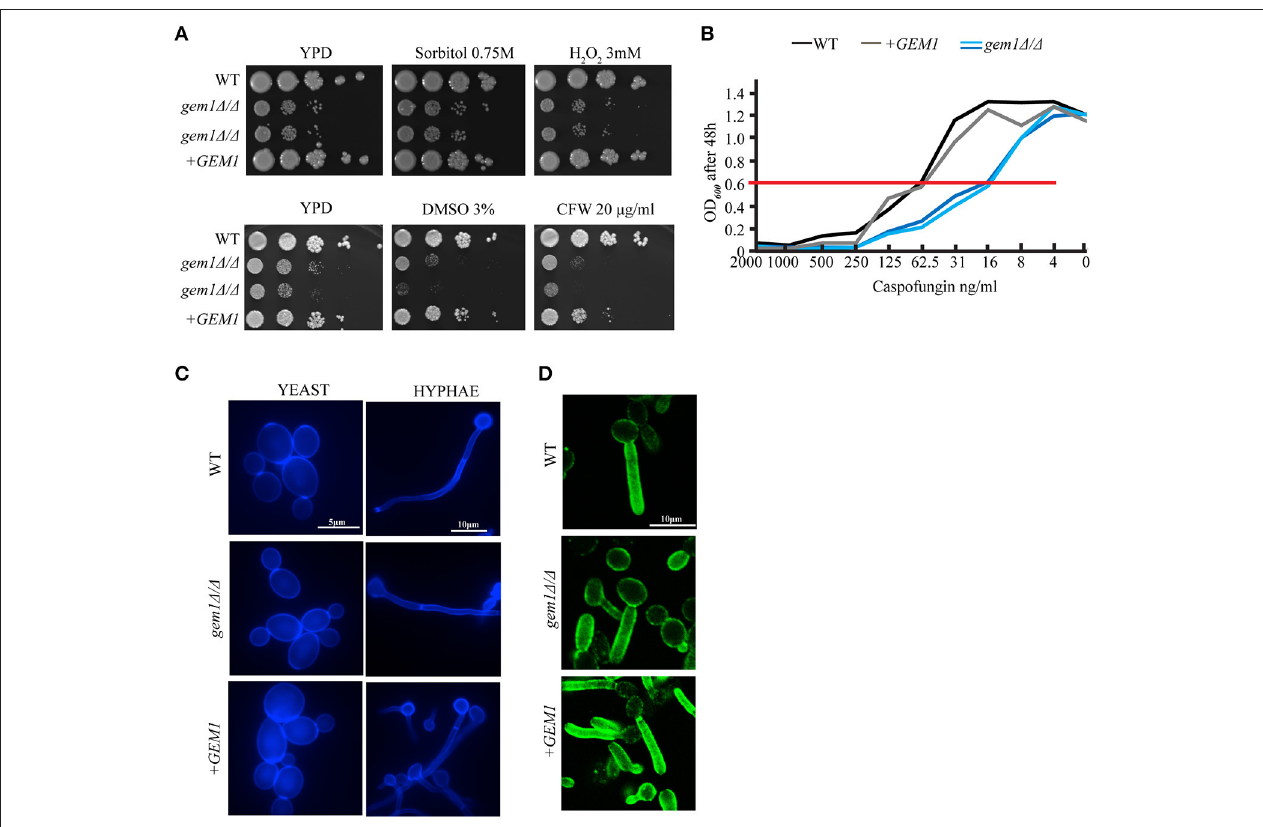
FIGURE 2 | Gem1 controls susceptibility to cell wall stress. (A) Growth of C. albicans wild type, gem1 1 / 1 mutants and the complemented strain ( + GEM1 ) was tested on YPD plates in the presence of the indicated drugs at 30 ◦ C. Ten-fold serial dilutions were spotted and plates were photographed after 2 days. (CFW, Calcofluor White). (B) Determination of caspofungin minimal inhibitory concentrations for wild type C. albicans , two independent gem1 1 / 1 mutants and the complemented strain ( + GEM1 ). OD 600 was measured after 48h of growth in YPD media at 30 ◦ C and plotted against the caspofungin concentrations used. The red line indicates the MIC 50 . Three independent experiments were performed, and gave the same result for the MICs. Shown is one representative experiment. (C) Calcofluor white staining of yeast and hyphae. Hyphal formation was induced for 3h in Spider medium at 37 ◦ C. (D) Immunofluorescence analysis of formaldehyde fixed cells was performed with the anti- β (1,3)-glucan antibody. Hyphae were induced in Spider media at 37 ◦ C for